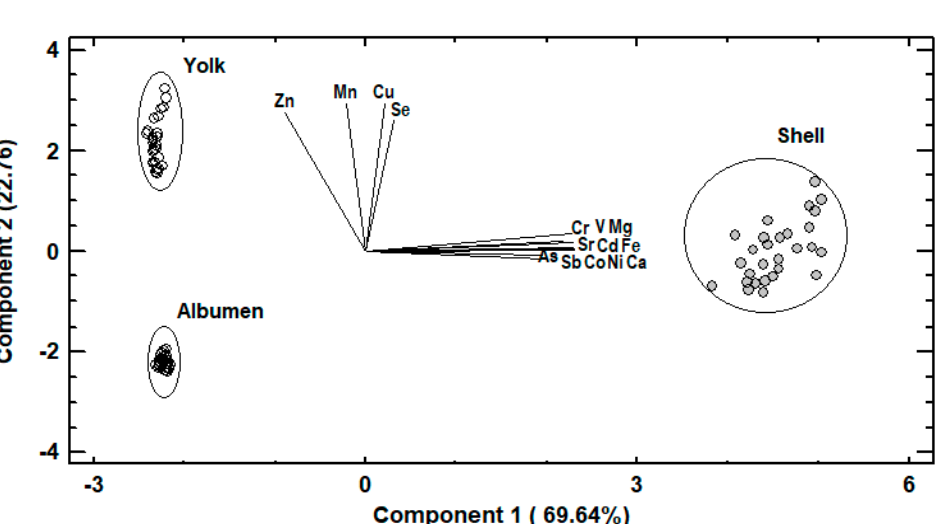
Figure 1. Principal components analysis. Loadings of trace and macro elements for the two first principal components and score plot of albumen, yolk or shell samples.